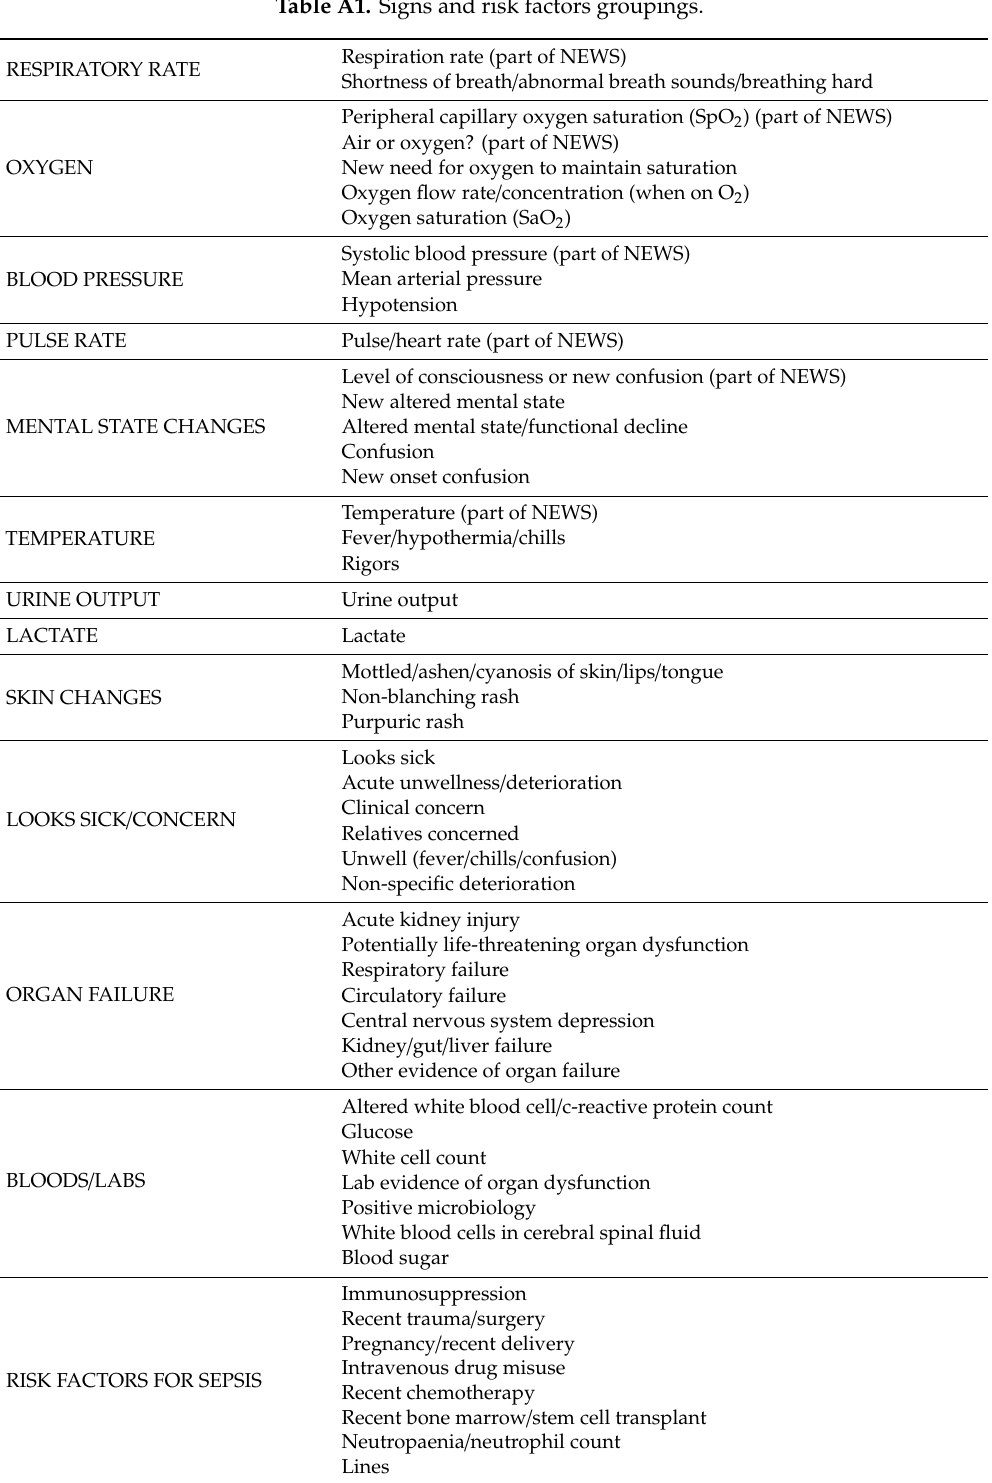
Table A1. Signs and risk factors